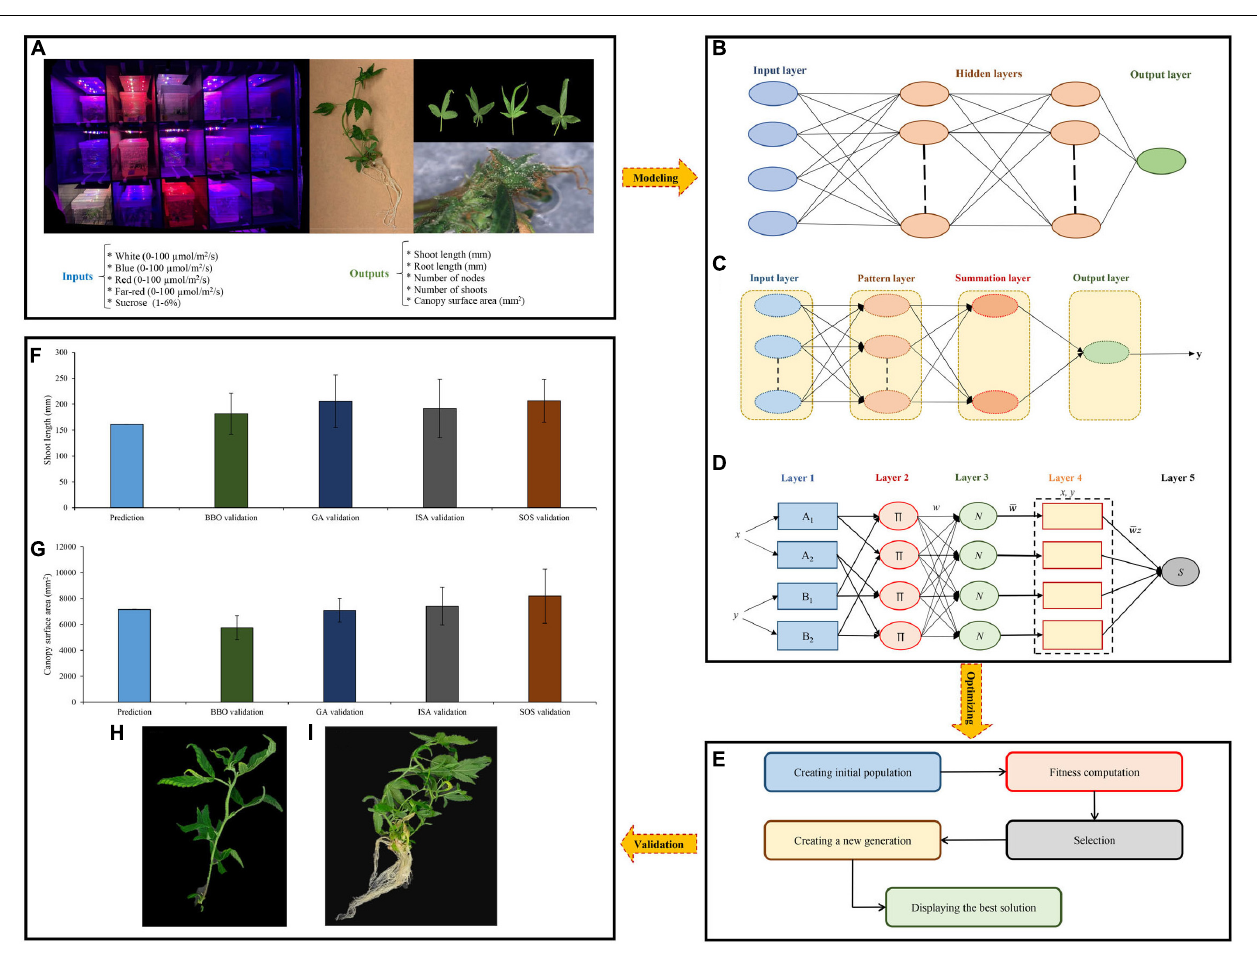
FIGURE 5 | Step-by-step methodology of the current study, including (A) data obtained, (B–D) data modeling through multilayer perceptron (MLP), generalized regression neural networks (GRNN), and adaptive neuro-fuzzy inference system (ANFIS), respectively, (E) main steps of optimization process through different optimization algorithms, (F,G) results of the validation experiment for shoot growth and canopy surface area, respectively, and (H,I) shoot growth and canopy surface area obtained from symbiotic organisms search